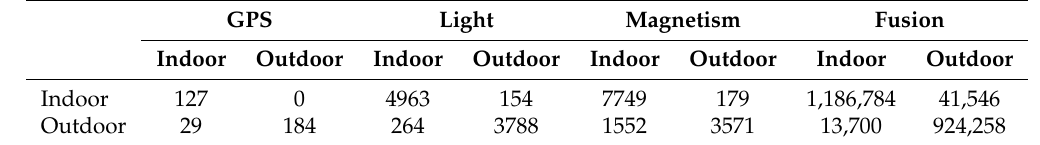
Table 6. Confusion matrix of Building